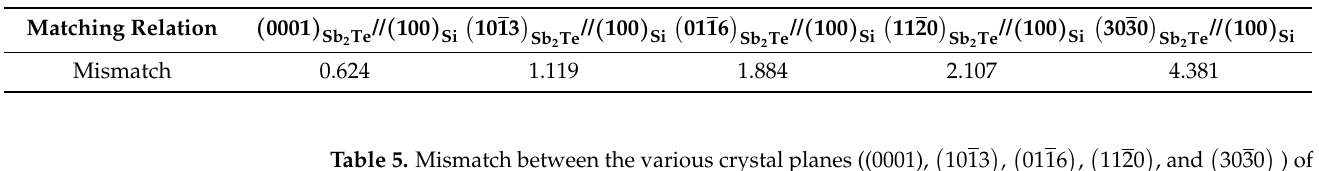
(cid:0) (cid:1) (cid:0) (cid:1) (cid:0) (cid:1) (cid:0) (cid:1) 1013 , 0116 , 1120 , and 3030 ) of